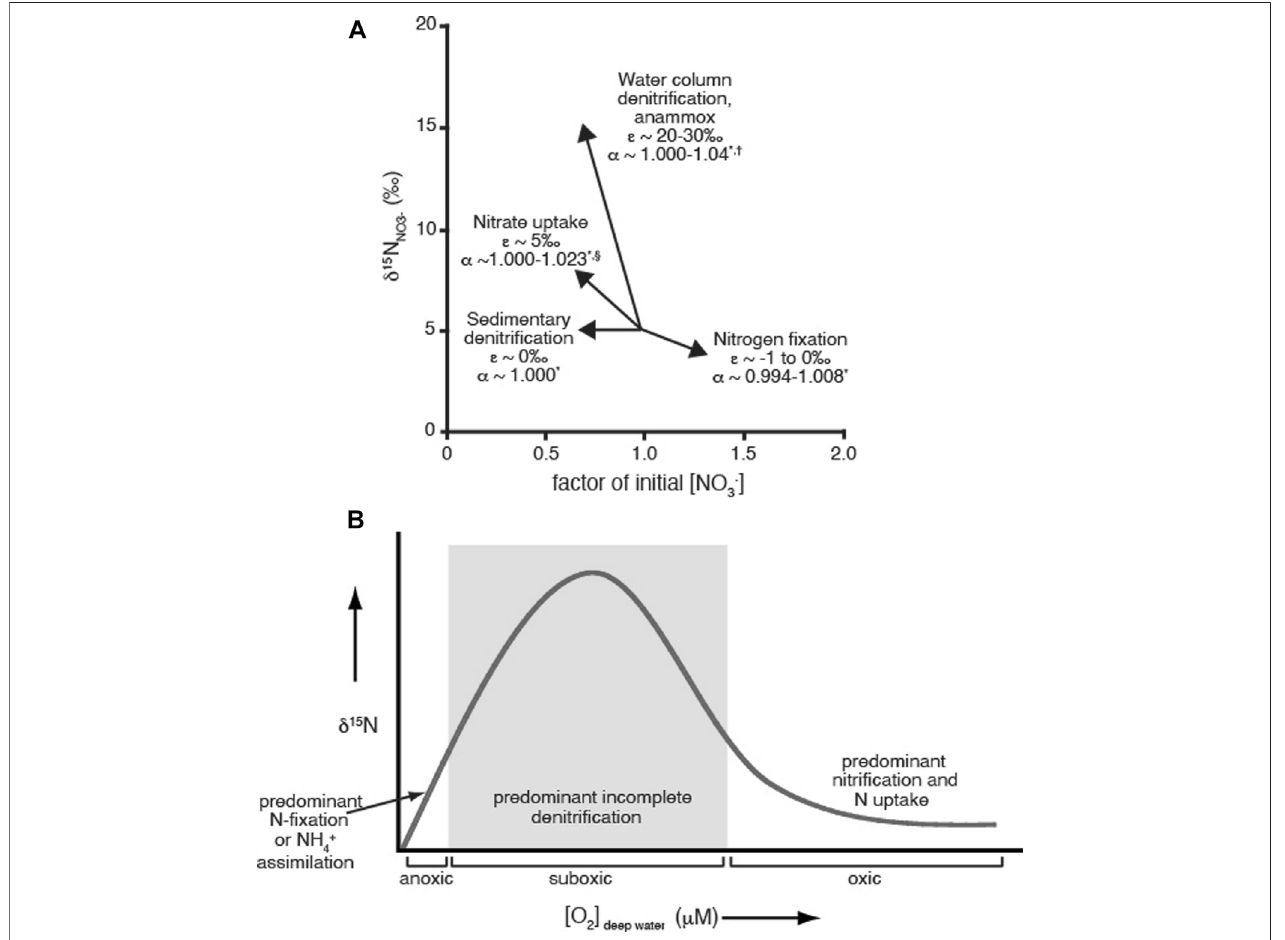
FIGURE1|(A) :Illustration ofselectednitrogenreactions thatoccurinmarine systemsshowingtheirinstantaneousimpactonnitrate δ 15 Nvalueandconcentration (assuming initial δ 15 N NO3- (cid:2) 5 ‰ ). Isotope effect ( ε ) values are from Sigman and Casciotti (2001); fractionation factor ( α ) ranges are taken from *Wada et al. 1980 and references therein, † Brunner et al. 2013 and § Talbot 2001 and references therein. Reprinted (modi fi ed) from the Encyclopedia of Ocean Sciences, Sigman DM, and Casciotti KL, Nitrogen Isotopes in the Ocean, p . 1884 – 1894, Copyright 2001, with author permission. (B) : Conceptual model illustrating how δ 15 N values can be used as a paleoredox proxy. As the predominant water column nitrogen reactions change in response to oxygen concentrations, the δ 15 N values for organic matter depositedinthesedimentisaltereddue tothecharacteristicisotopicfractionationfactorsforeachreaction.Reprinted (modi fi ed)from ChemicalGeology 360 ,QuanTM, Adigwe EN, Riedinger N, and Puckette J, Evaluating nitrogen isotopes as proxies for depositional environmental conditions in shales: Comparing Caney and Woodford Shales in the Arkoma Basin, Oklahoma, p. 231 – 240 Copyright 2013, with permission from Elsevier.